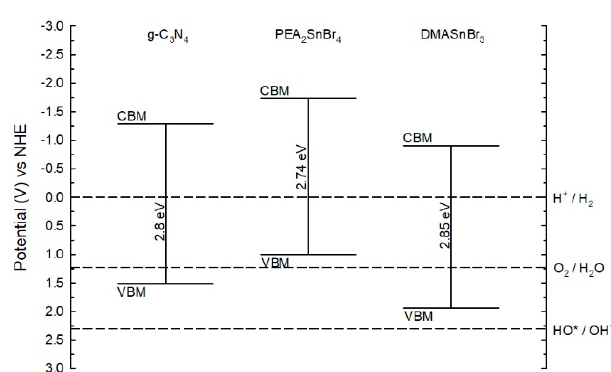
Figure 3. Scheme of the redox potentials (pH 7 vs NHE) of relevant reactions in relation to the band edges positions of as-prepared g-C 3 N 4 and metal halide perovskites (MHPs).